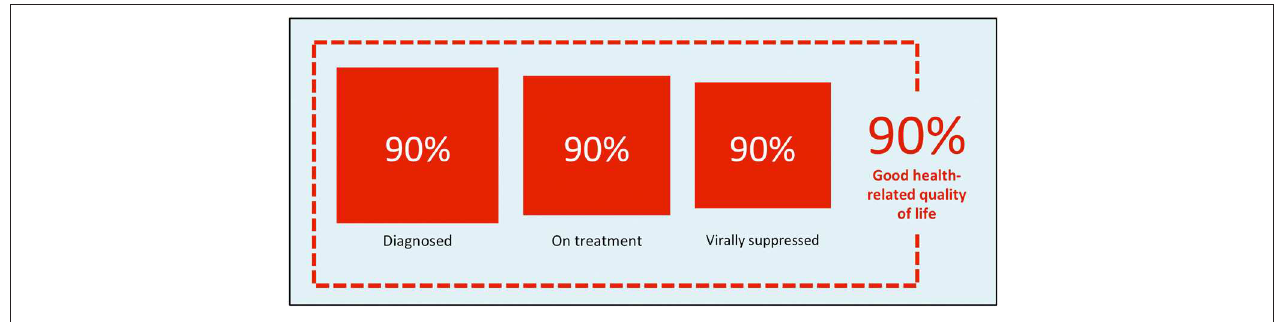
FIGURE 1 | A proposed “fourth 90” target for health-related quality of life [source: Safreed-Harmon et al.